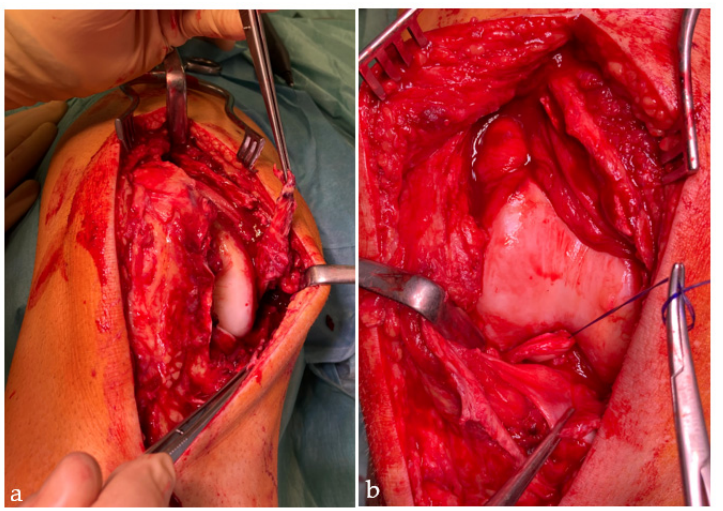
Figure 2. ( a ) Intraoperative view with a torn medial collateral ligament (for-ceps) and ( b ) bucket handle tear of both menisci.